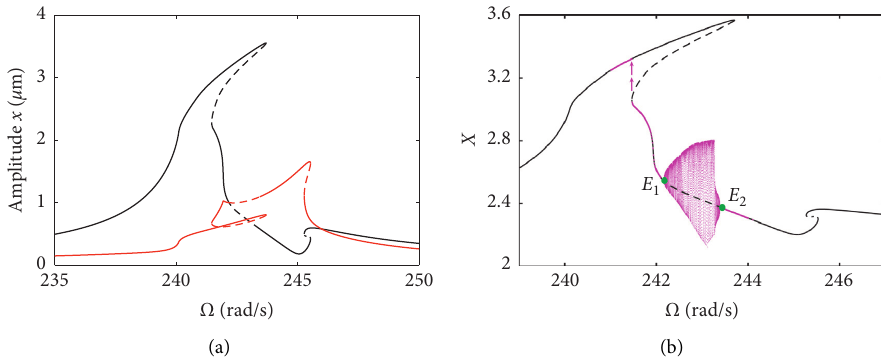
Figure 12: Resonant response characteristics for δ � − 1.2 μ m and c � 200Ns/m: (a) period-1 frequency-response peak-to-peak curves and 0 (b) numerical bifurcation diagram of X ( τ ) when Ω is sweeping down (magenta dots).